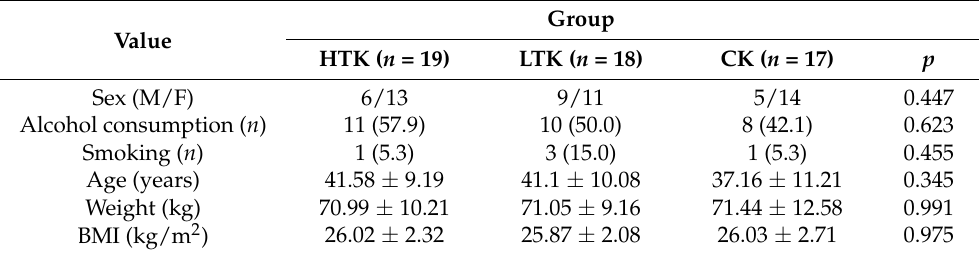
Table 2. General characteristics of